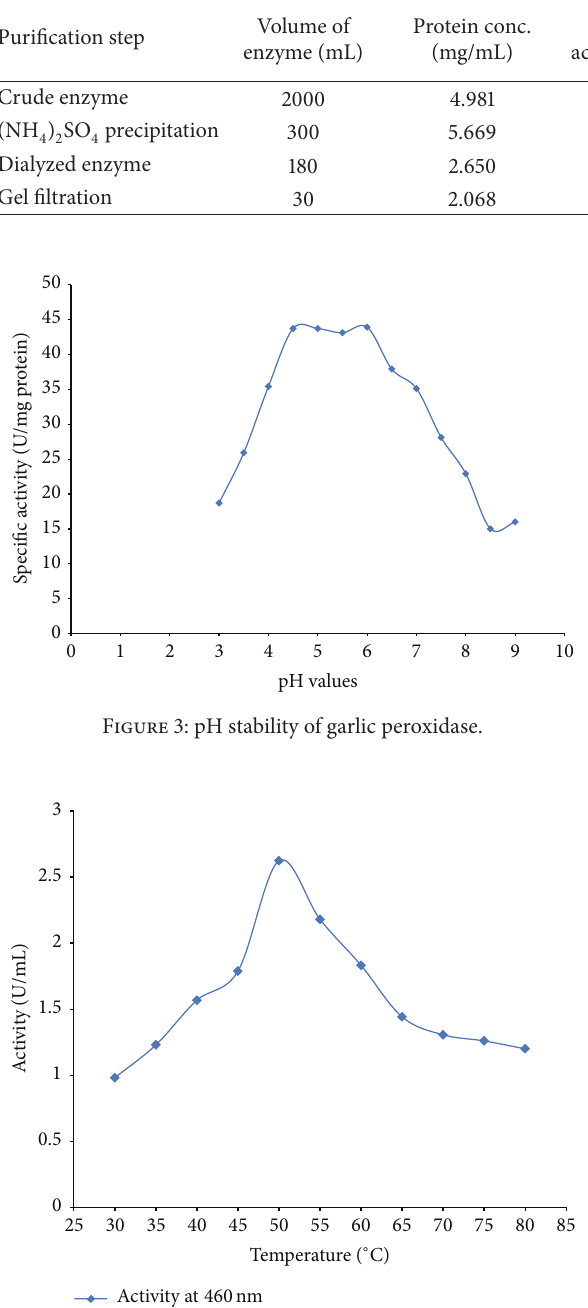
Figure 4: Effect of temperature on peroxidase activity.